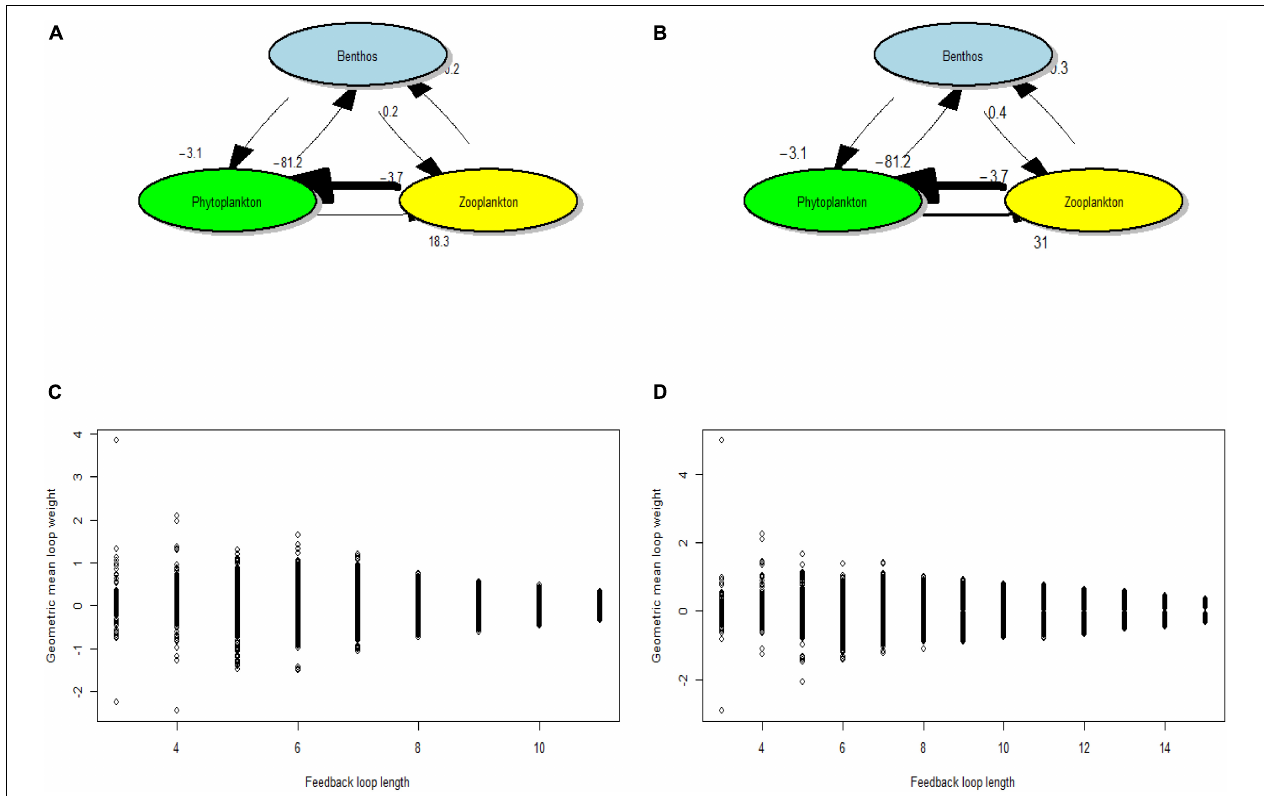
FIGURE 4 | The mean loop weights that are defined as the geometric mean of the values of the interaction strengths in the loop and their maximum of different lengths in the summer and autumn in Juehua Island of 2019. The maxima both occur at the smallest omnivory feedback loop (length three). (A) Benthos, zooplankton, and phytoplankton have maximum loop weight among all loops in the summer of 2019 in Juehua Island since the interaction strength from zooplankton to phytoplankton is –81.2 that far outweigh the other interaction strengths. (B) The maximum weight loop in autumn is the same as the one in summer. (C) All loop weights of different lengths in summer. (D) All loop weights of different lengths in autumn.